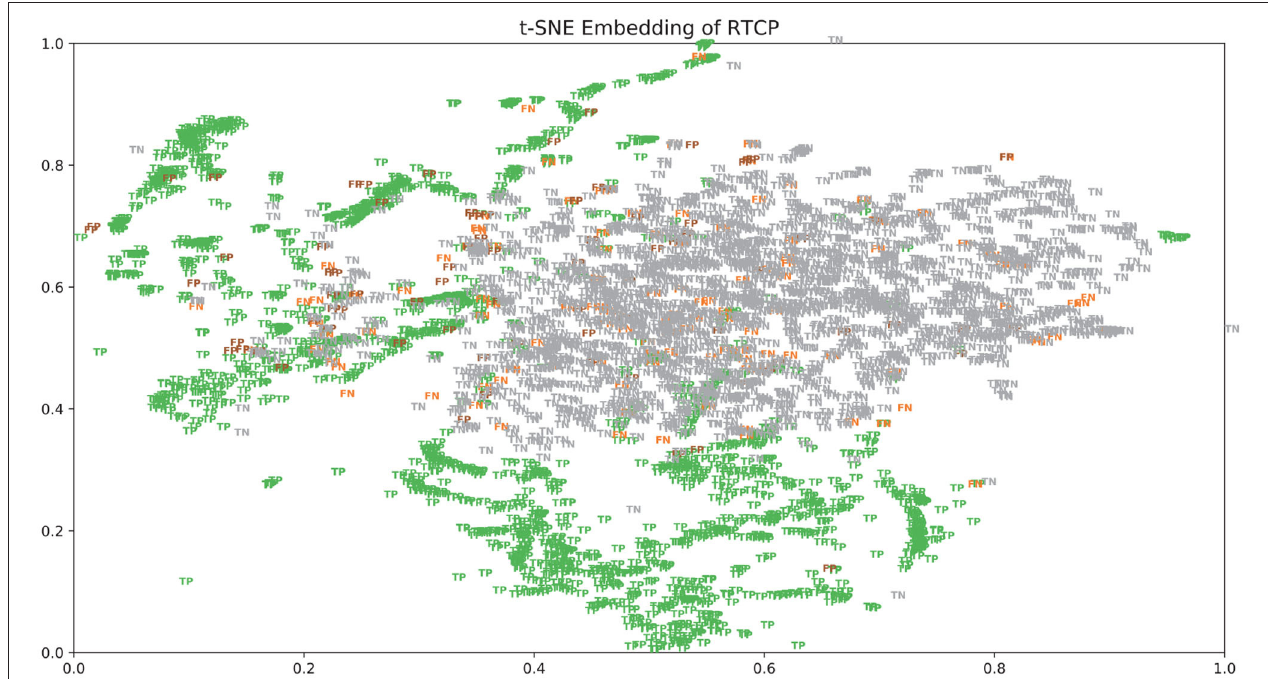
FIGURE 8 | The distribution of the samples in ABC_2020 in two-dimensional space.